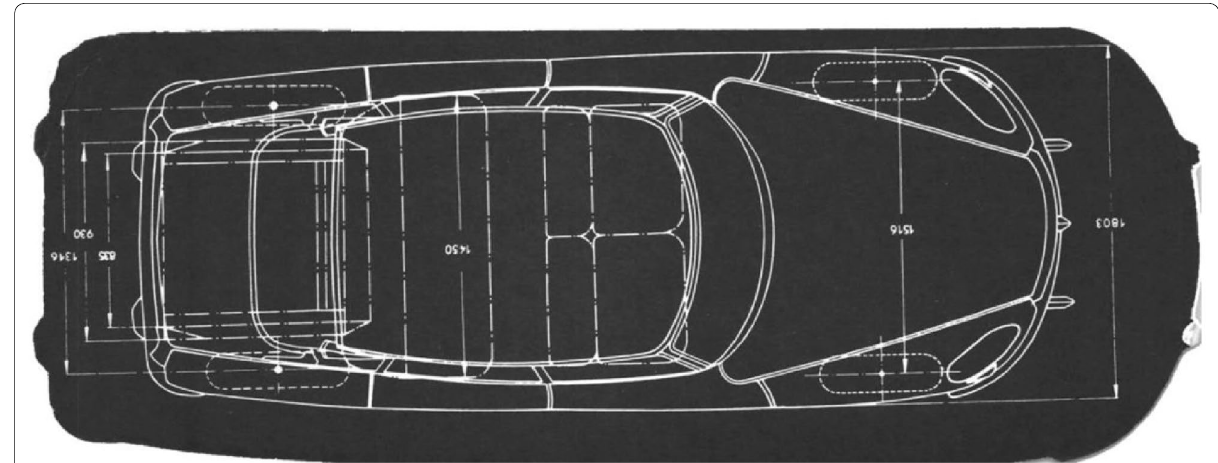
Fig. 6 Interior side of the cover of Smithson (1983). Credits: Smithson Family